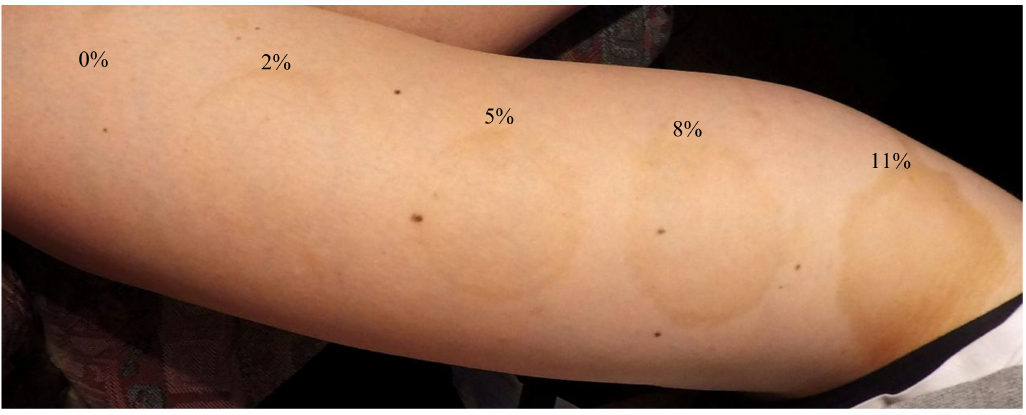
Figure 5. Skin coloring 12 h after removal of MC patches with DHA, which were applied for 30 min (concentration of DHA was expressed in %).